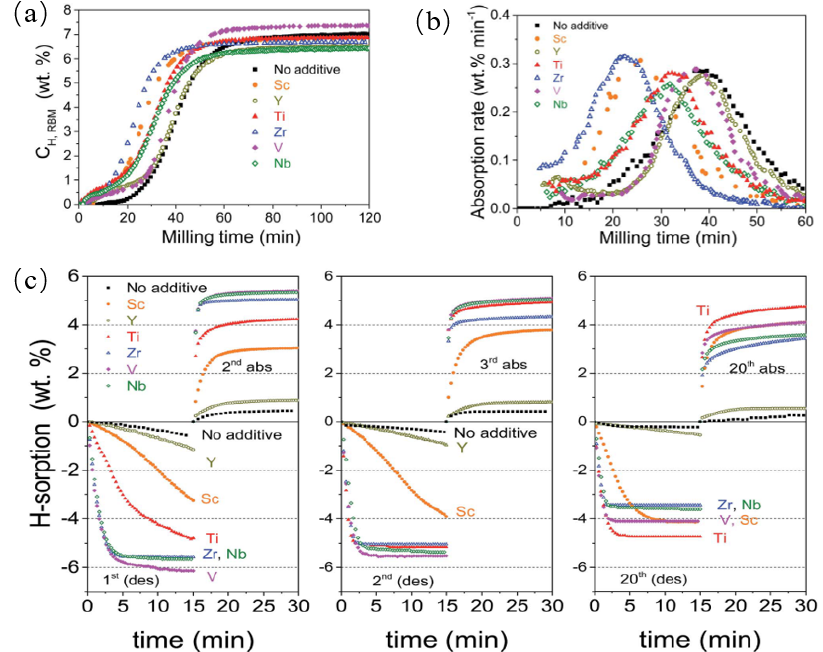
Figure 6. Hydrogen desorption curves (( a ), desorption pressure of 0.015 MPa, 573 K) and absorp- tion curves (( b ), absorption pressure is 1.0 MPa, 302 K) of Mg–Tm composites. (Reproduced with